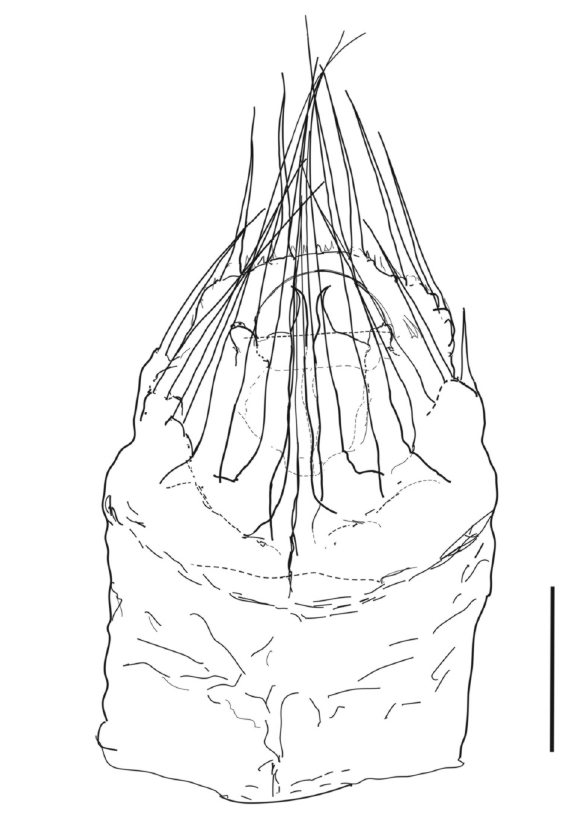
Fig. 6. Siro franzi Karaman & Raspotnig sp. nov., paratype, ♂ (IKC1538). Spermatopositor. Scale bar = 50